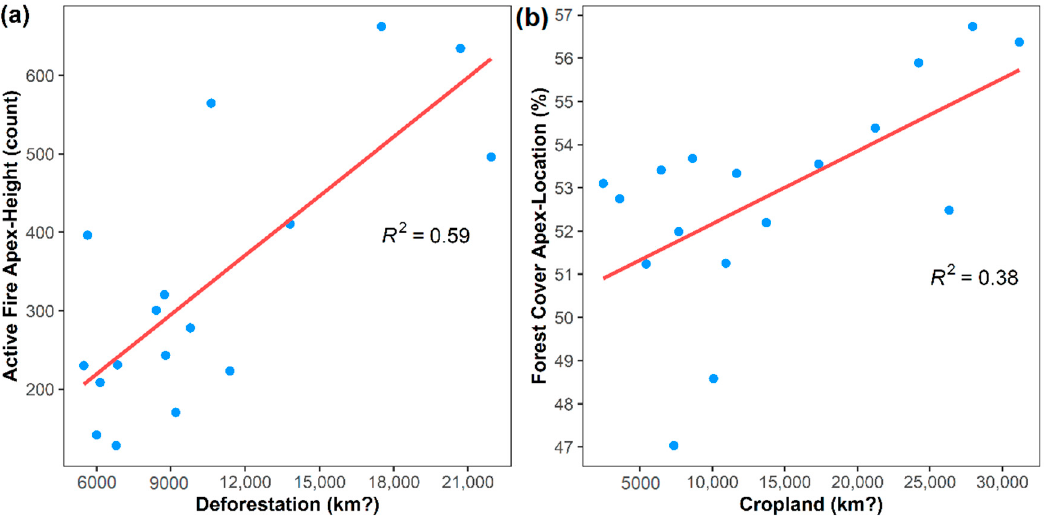
Figure 6. Linear models of the significant variables used to describe active fire apex-height and forest cover apex-location. ( a ) Active fire apex-height by annual deforestation. ( b ) Forest cover apex-location by cropland area.